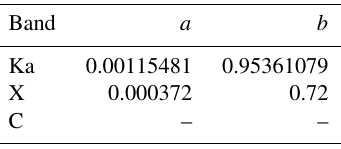
Table A1. Attenuation coefficients used for path-integrated attenu- ation filtering, where A H = aZ b